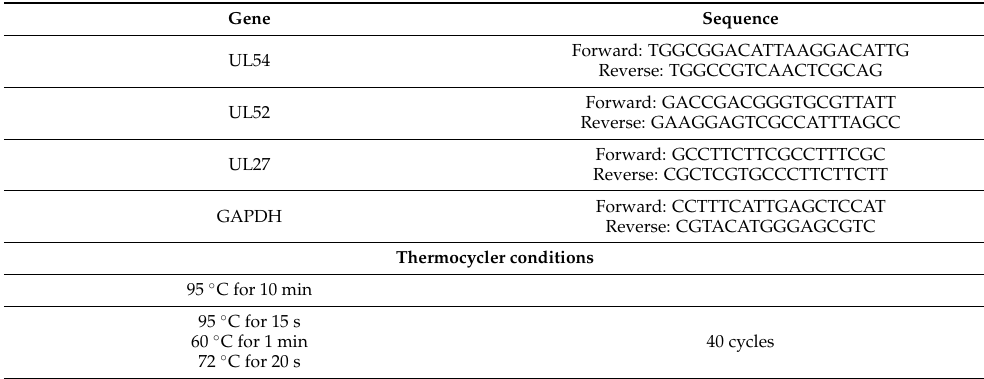
Table 1. Primer sequences and thermal conditions used for real-time